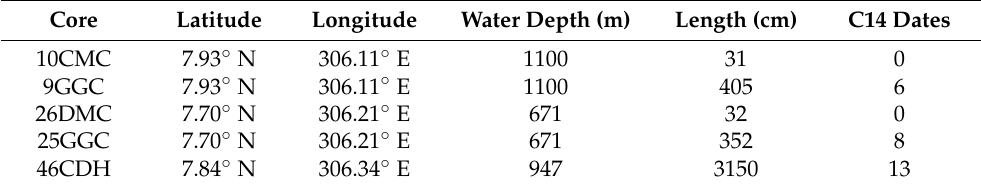
Table 1. Site locations and descriptions of Demerara Rise cores discussed in this